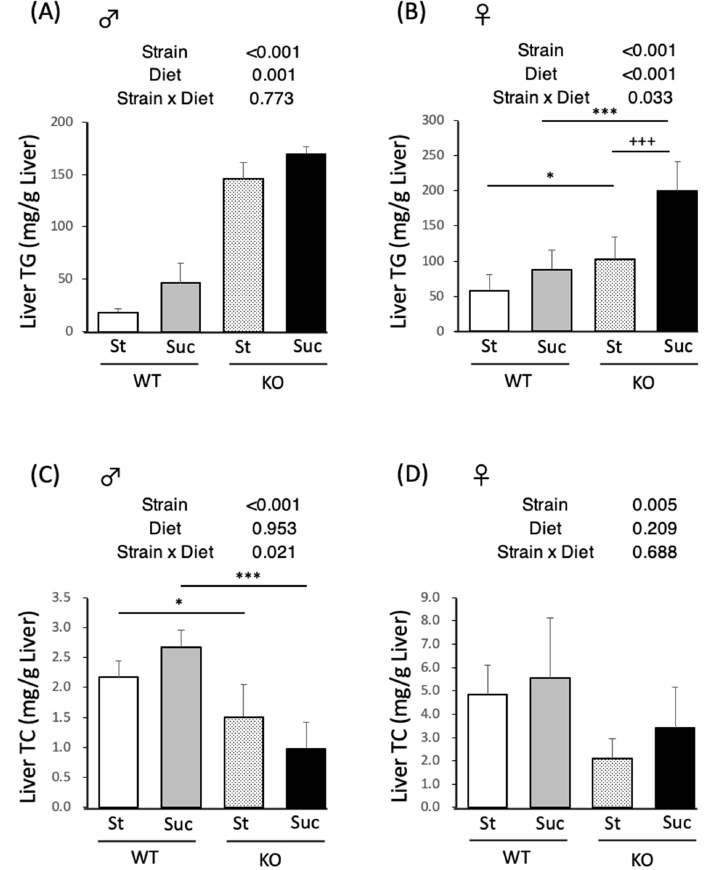
Figure 1. Liver TG and TC content according to diet. ( A ) Liver TG content in wild-type and PPAR α − / − male mice. ( B ) Liver TG content in wild-type and PPAR α − / − female mice. ( C ) Liver TC content in wild-type and PPAR α − / − male mice. ( D ) Liver TC content in wild-type and PPAR α − / − female mice. The inserted tables show the two-way ANOVA p values. * p < 0.05, *** p < 0.001 between mice fed the same diet. +++ p < 0.001 between mice of the same strain. Data are expressed as the mean ± SEM, n = 6. WT, wild-type mice; KO, PPAR α − / − mice; St, starch diet; Suc, high-sucrose diet.